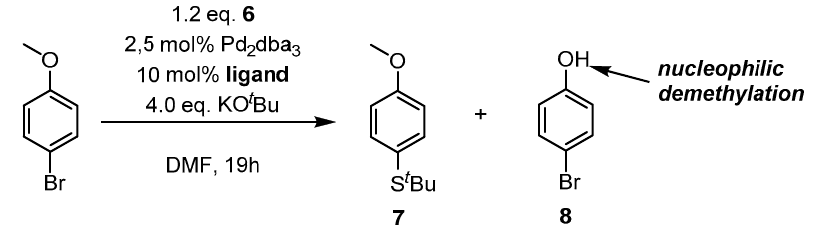
Scheme 2. General reaction Scheme for the screening of optimal conversion of 4-bromoanisole. Table 1. Screening of various phosphine ligands for C-S cross coupling to 7 . Table 1. Screening of various phosphine ligands for C-S cross coupling to 7 .